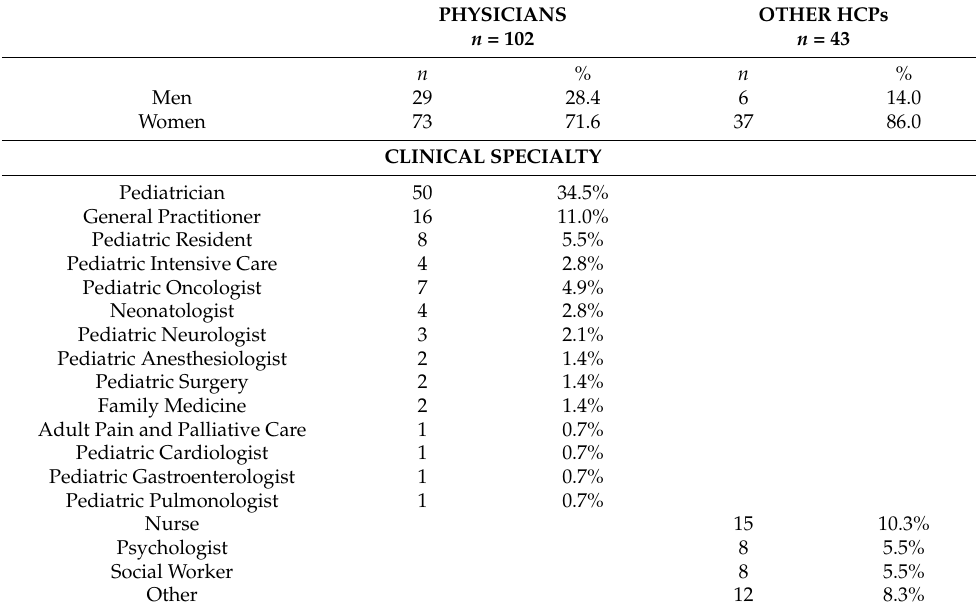
Table 1. Characteristics of participants.